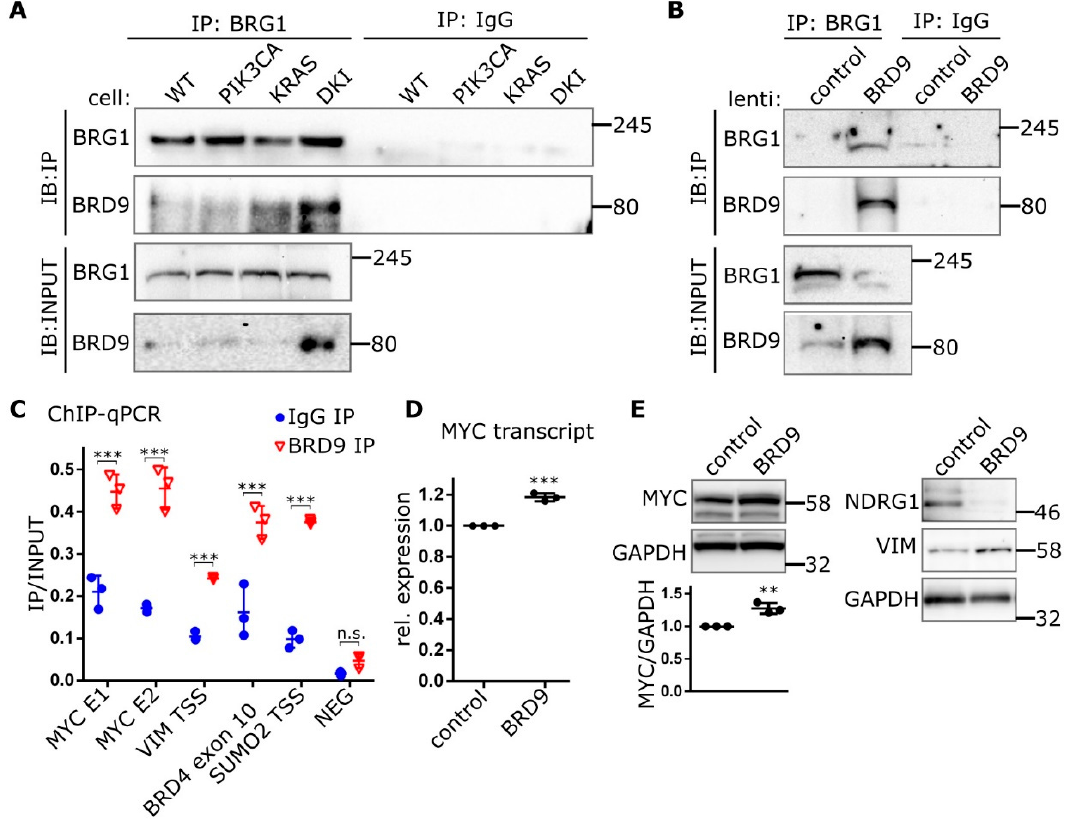
Figure 5. BRD9 is part of the SWI-SNF complex and binds MYC enhancer sequences. ( A ) Immunoblots showing Co-IP of BRD9 with the SWI-SNF subunit BRG1 from MCF-10A nuclear extracts or ( B ) nuclear extracts isolated from DKI cells transduced with lenti-BRD9. ( C ) ChIP data (Mean ± SD) showing BRD9 occupancy at MYC super-enhancer and VIM promoter DNA regions. BRD4 and SUMO2 represent positive control sequences; NEG represents a non-specific negative control sequence. ( D ) RT-qPCR (Mean ± SD) of MYC transcript in DKI cells transduced with empty (control), or BRD9-encoding lentiviral constructs. ( E ) Immunoblot data showing MYC (with densitometric quantification, lower panel), target NDRG1, and VIM expression in DKI cells transduced with empty (control), or BRD9-encoding lentiviral constructs. **, p < 0.01; ***, p < 0.001 (unpaired t-test); n.s., not significant.